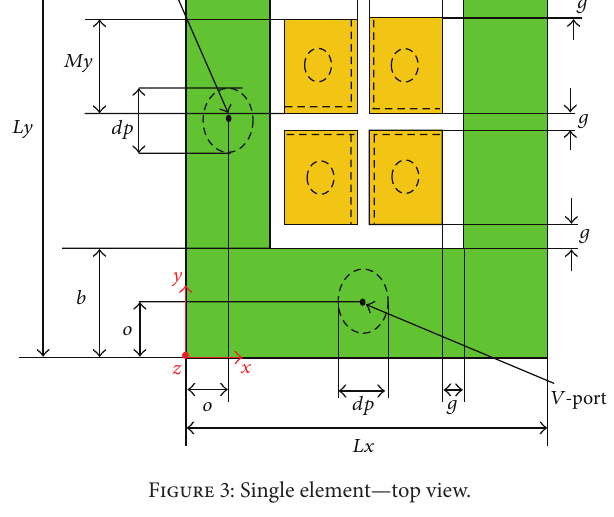
Figure 3: Single element—top view.